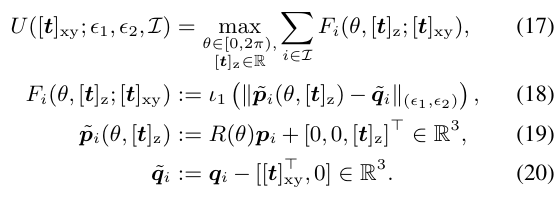
Figure 3. Optimal parameter ( θ, [ t ] z ) , which is on most overlapped region for multiple rectangles (slashed-red region), can be found as pair of ( θ i ,t j ) , where θ i and t j are a vertex of